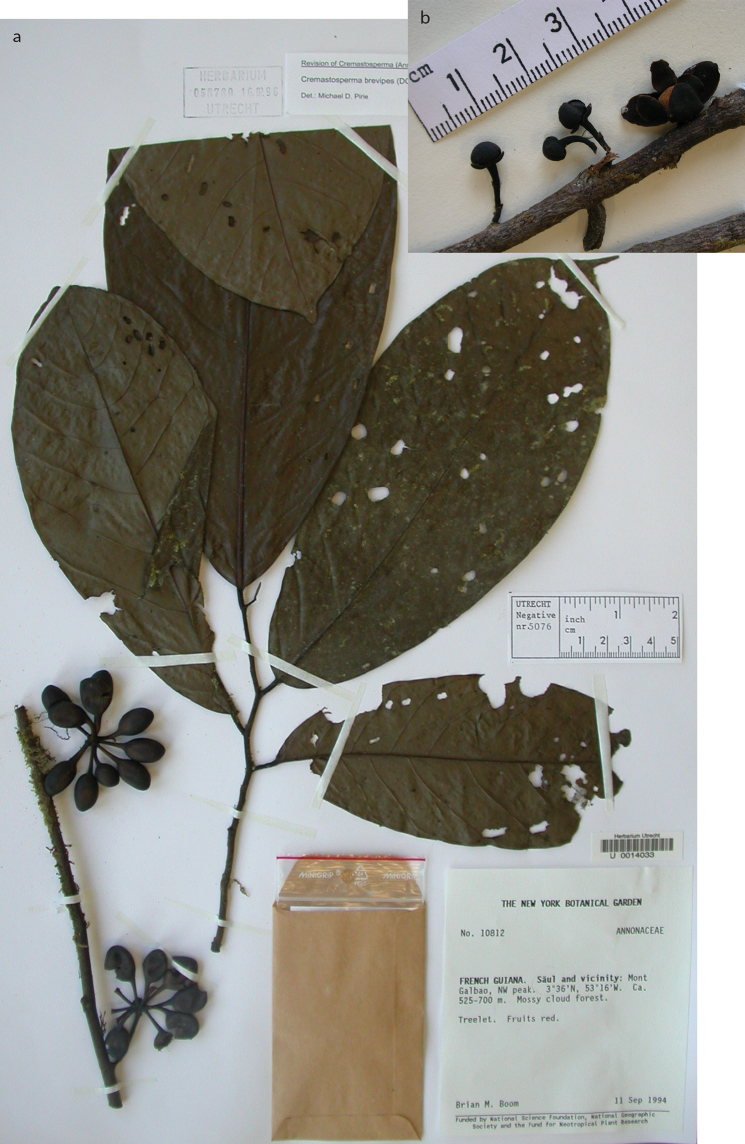
Cremastospermabrevipes (DC.) R.E.Fr. a fruiting specimen b flower buds (aBoom 10812bPrévost 3446).